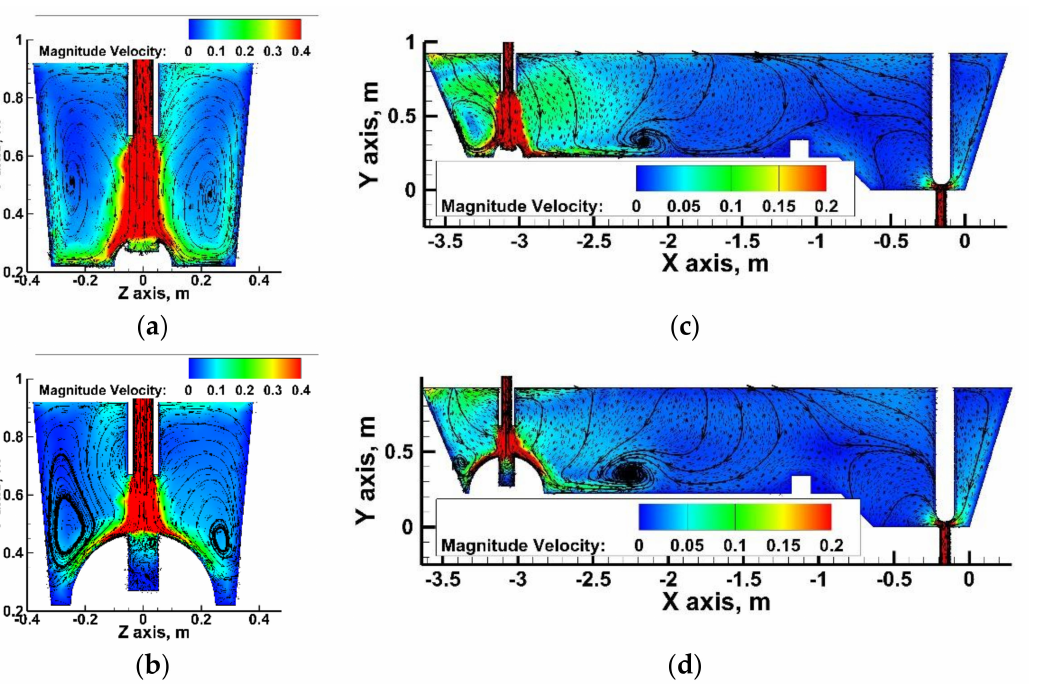
Figure 5. Liquid steel flow in the tundish with modified hemisphere SFC: ( a ) pouring zone (transver- sal plane—case No. 6), ( b ) pouring zone (transversal plane—case No. 9), ( c ) pouring and stopper rod zones (longitudinal plane—case No. 6), ( d ) pouring and stopper rod zones (longitudinal plane—case No.